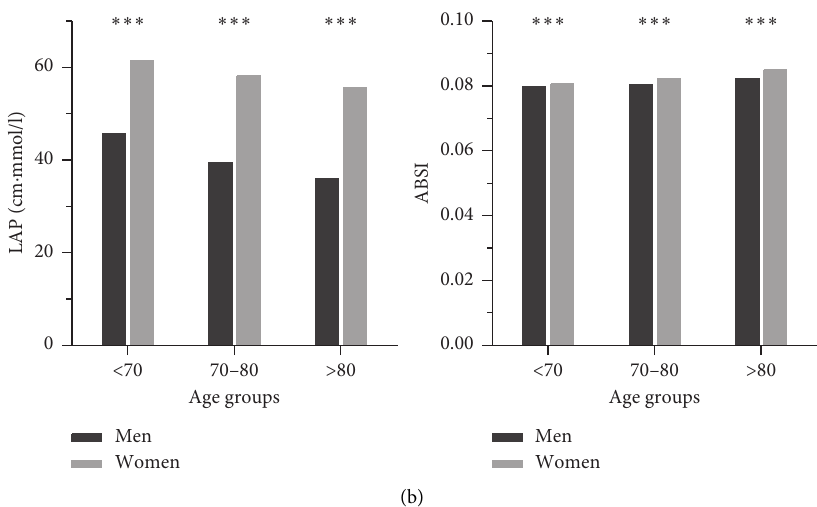
Figure 1: The difference in anthropometric indicators between genders and ages. ∗ P < 0.05, ∗∗ P < 0.01, and ∗∗∗ P < 0.001.